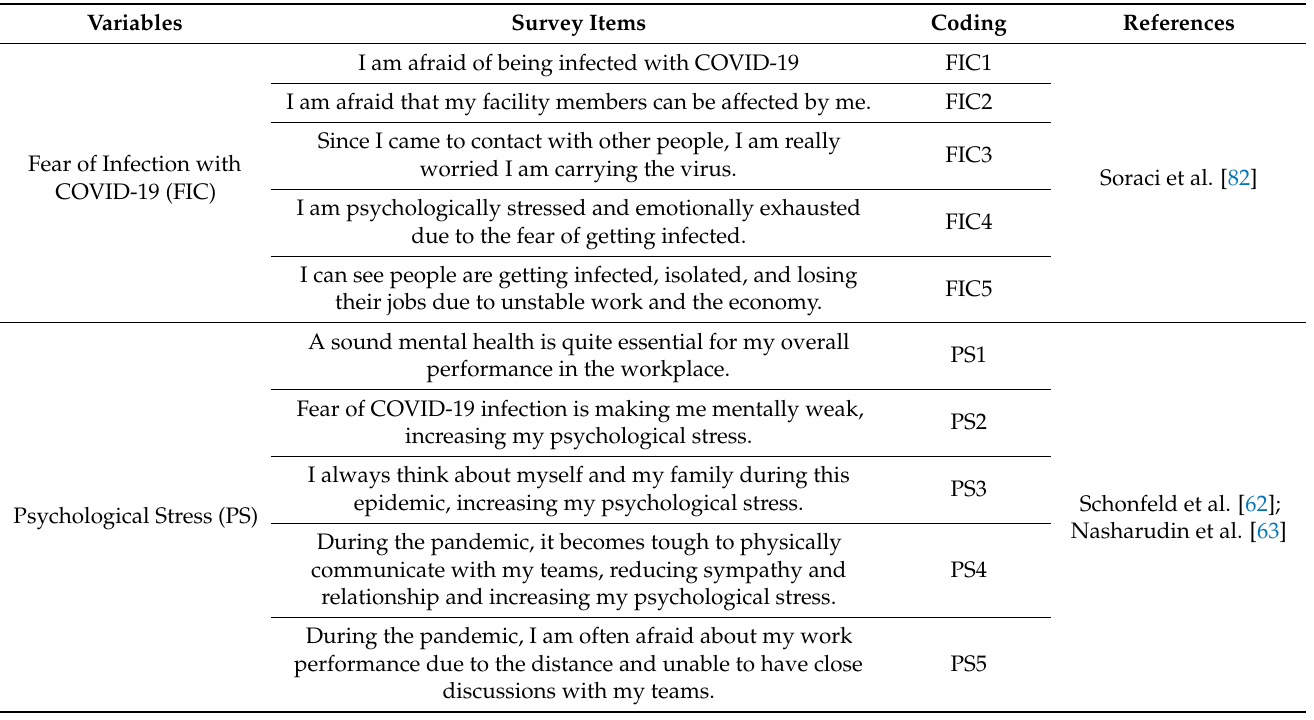
Table 2. Constructs and survey items with literature